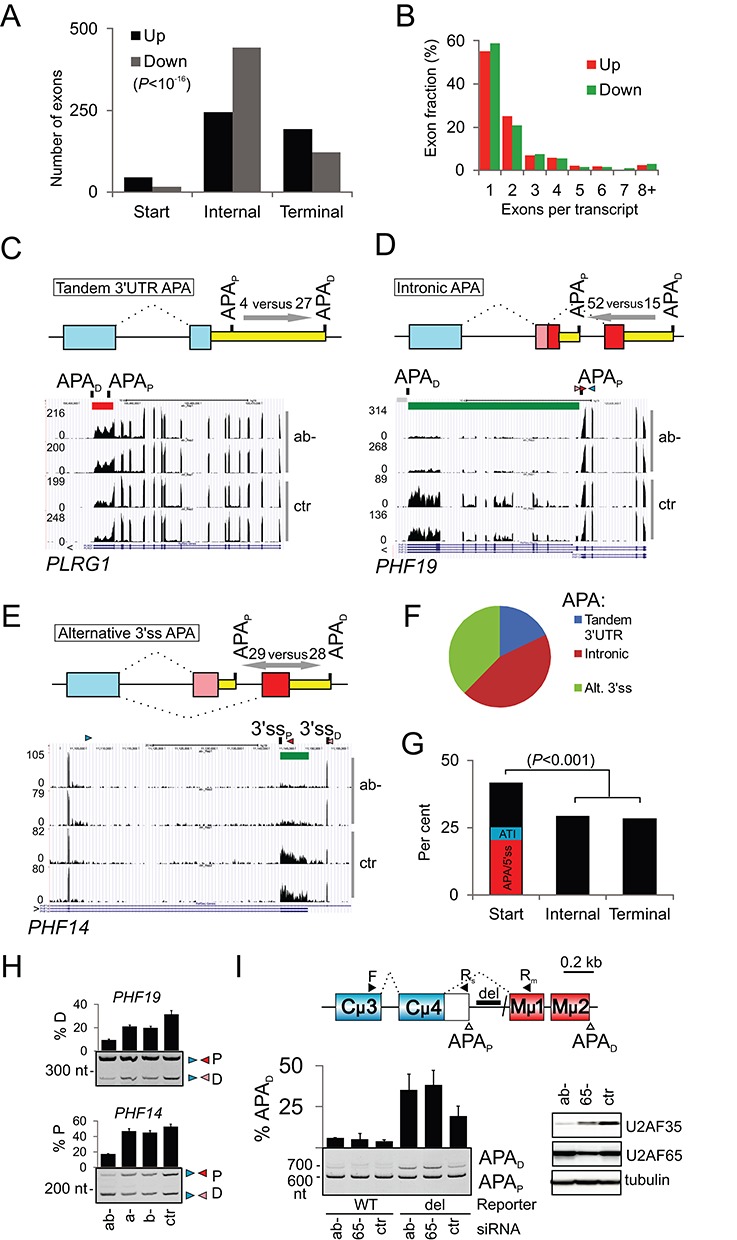
Characterization of global changes in APA induced by U2AF35 depletion. (A) Distribution of start, internal and terminal exons upregulated and downregulated in cells depleted of U2AF35. P-value was derived from a χ2-test for the 3×2 contingency table. P-value for the first exons versus the pool of internal and terminal exons was <10−7. (B) A high proportion of transcripts with ≥2 differentially expressed exons. (C-E) APA site usage in the indicated APA categories. Number of proximal and distal APA sites altered in depleted cells is shown above arrows that indicate shifts in APA site usage. APAP, APAD, proximal and distal polyadenylation sites. Upregulated and downregulated exons are indicated by red and green rectangles throughout. Each category is schematically shown at the top; yellow rectangles are 3′UTRs, blue boxes are constitutive exons, red and pink boxes are alternative exons. Splicing is denoted by dotted lines. (F) Frequency distribution of APA categories altered in ab- cells. (G) Breakdown of start, internal and terminal exons for Cufflinks-positive genes. APA/5′ss, altered APA or 5′ss of the first intron in ab- cells; ATI, annotated alternative transcription initiation sites altered in ab- cultures. P-value was computed as in panel A. (H) Validation of intronic/alternative 3′ss APA site usage in two plant homology domain-encoding genes shown in panels D and E. PCR primers are in Supplementary Table S4. (I) Control of mouse intronic APA site usage by human U2AF35. Schematics of the mouse IgM minigene with APA sites giving rise to membrane (APAD) and soluble (APAP) immunoglobulins M (upper panel). Del, deletion of the RNA polymerase II (polII) pausing site (100). The lower panel shows RNA products of the wild-type and deletion-containing IgM minigenes transfected into HEK293 cells individually depleted of each U2AF subunit. Final concentration of U2AF65 siRNA was 40 nM. Immunoblot is to the right.